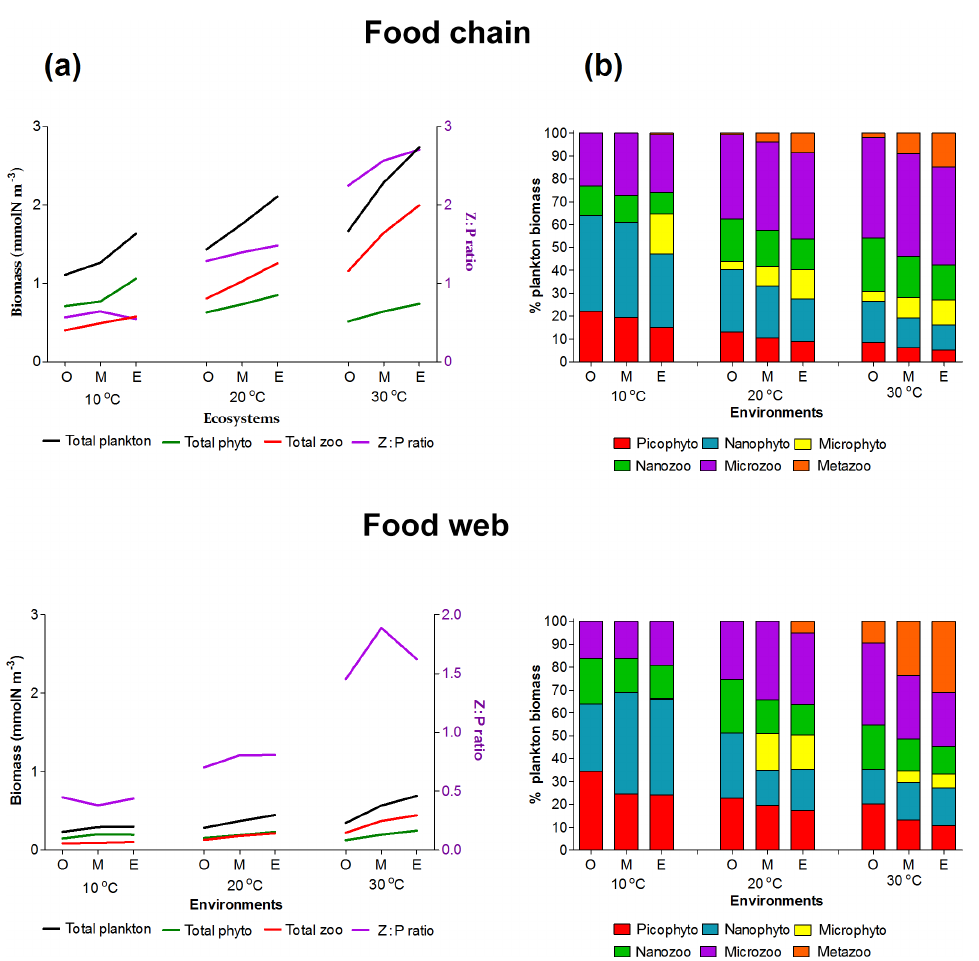
Figure 3. Plankton total biomass and group diversity for all environments (O: oligotrophic, M: mesotrophic and E: eutrophic environments). (a) Right axis: biomass of phytoplankton (green line), zooplankton (red line) and total plankton (black line) (mmolNm − 3 ). Left axis: zooplankton:phytoplankton biomass ratio (purple line). (b) Relative (%) biomass of phytoplankton and zooplankton size